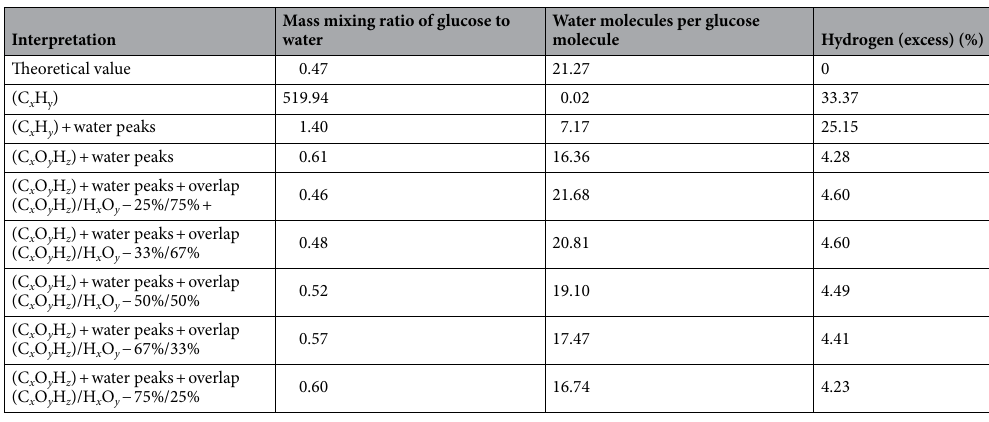
Table 4. Calculated stoichiometry by different peak interpretation